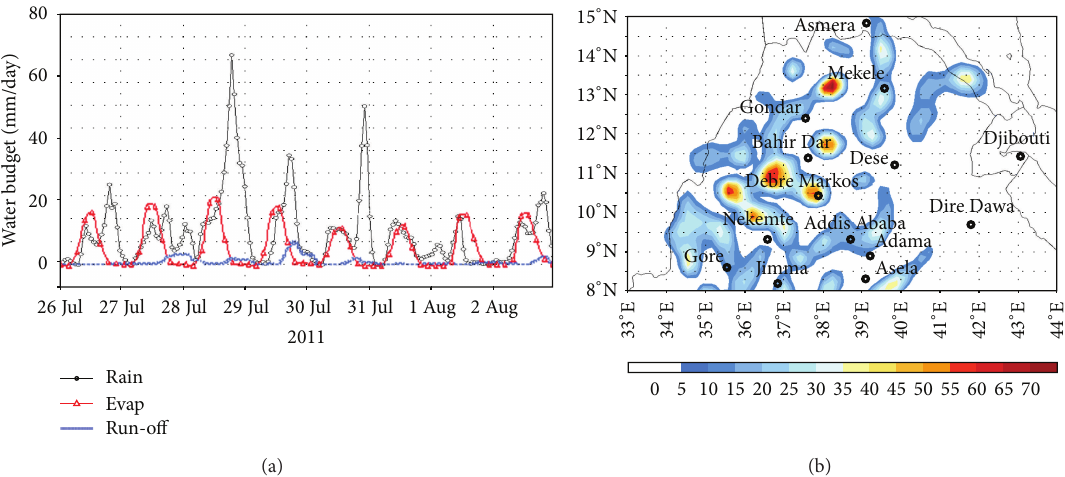
Figure 3: (a) CFS rainfall, evaporation, and runoff hourly time series for 1 ∘ grid-cell centered on 11 ∘ N, 37 ∘ E in the period 26 July–2 August, 2011. (b) CFS mean rainfall map (mm/day) on 29 July with urban